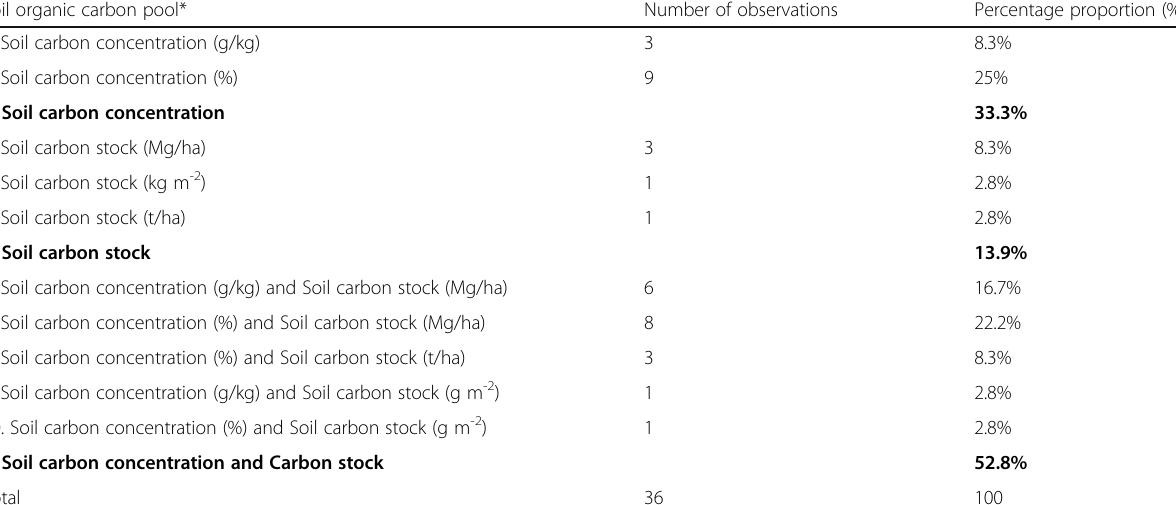
Table 2 Soil organic carbon pools and different units reported by referred authors Soil organic carbon